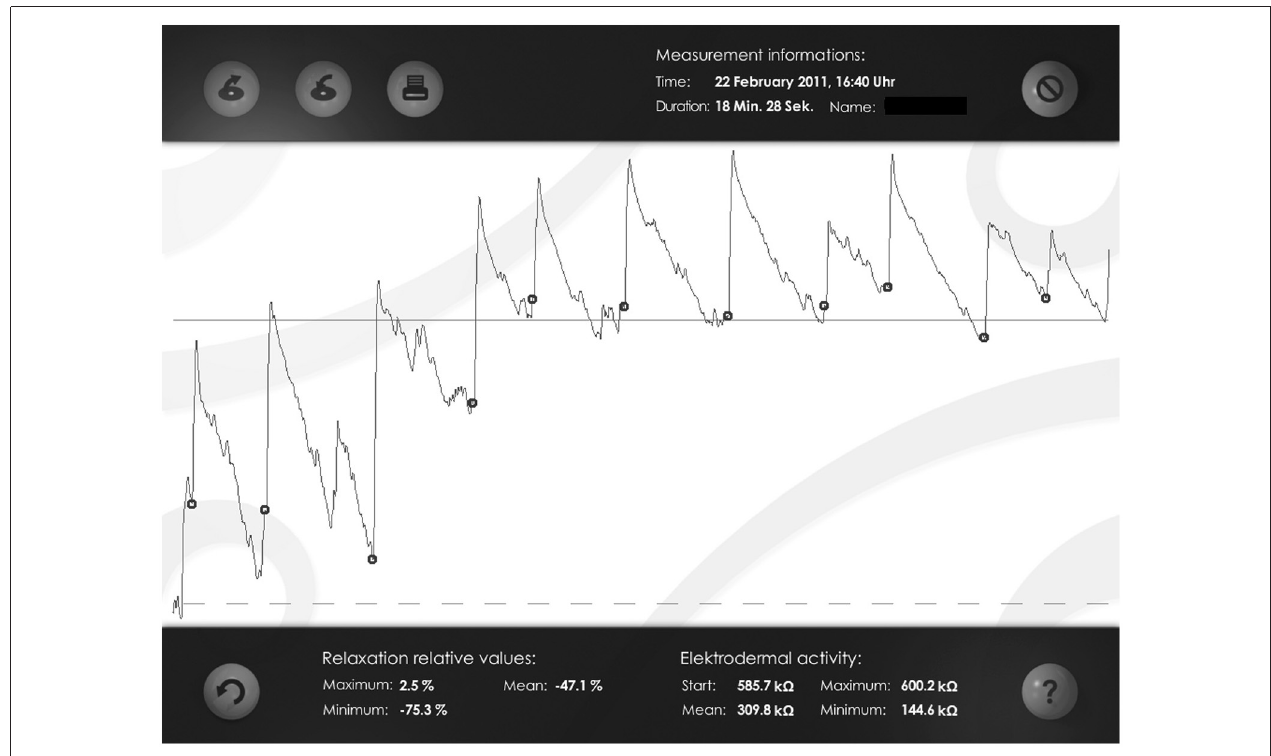
FIGURE 2 | Examples of participants’ biofeedback session with several successful alerts . The dots indicate the start of a self-alert episode, which is followed by a clear increase (peak) in participants’ Skin Conductance Response